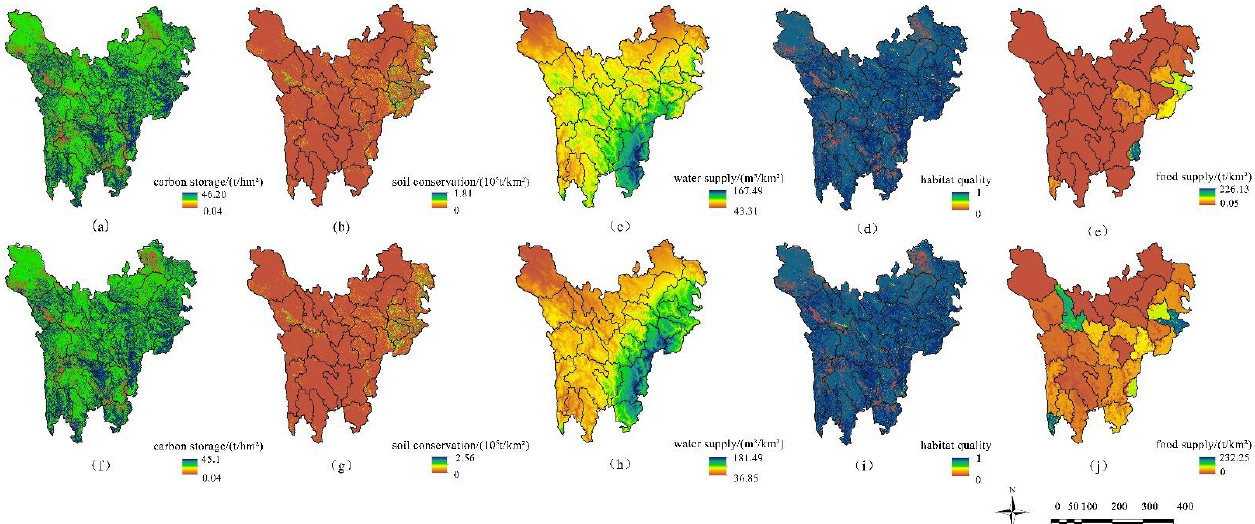
Figure 3. Changes over 20 years and spatial distribution characteristics of ecosystem services in western Sichuan Plateau: ( a – e ) mean ecosystem services in 2000 and ( f – j ) mean ecosystem services in